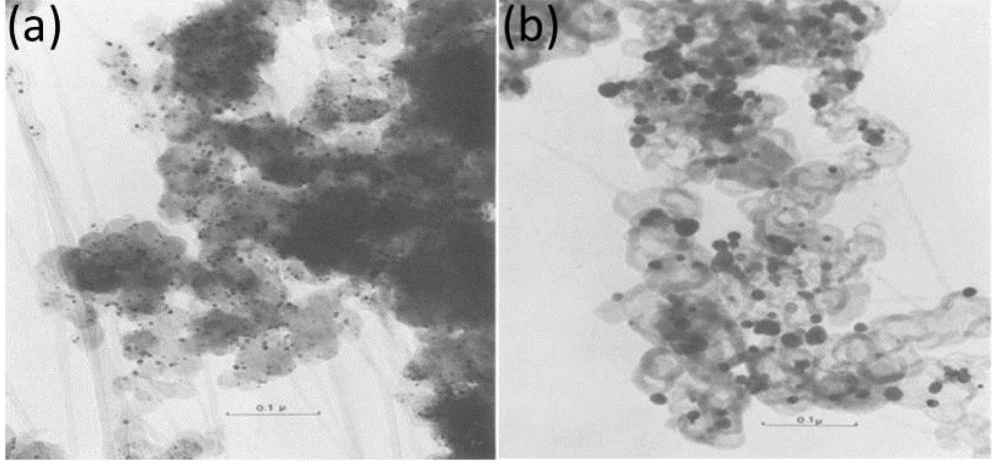
Figure 2. PEM fuel cell catalyst layer with support before ( a ) and after ( b ) use. Darker dots are Pt nanoparticles and the brighter material is carbon. [7] (Adapted from this reference with the permission of the Journal of Electrochemical